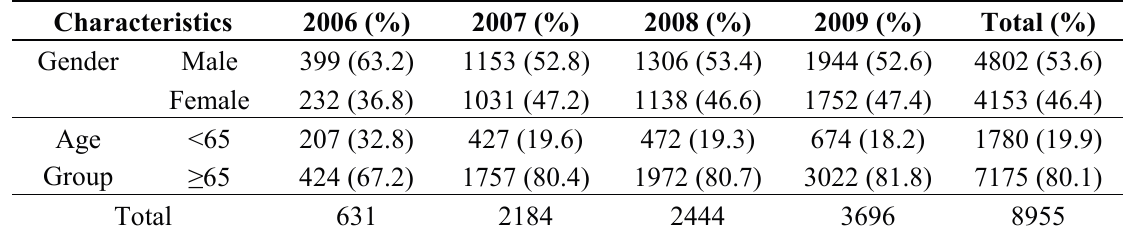
Table 1. Description of characteristics of all subjects collected during 2006–2009.